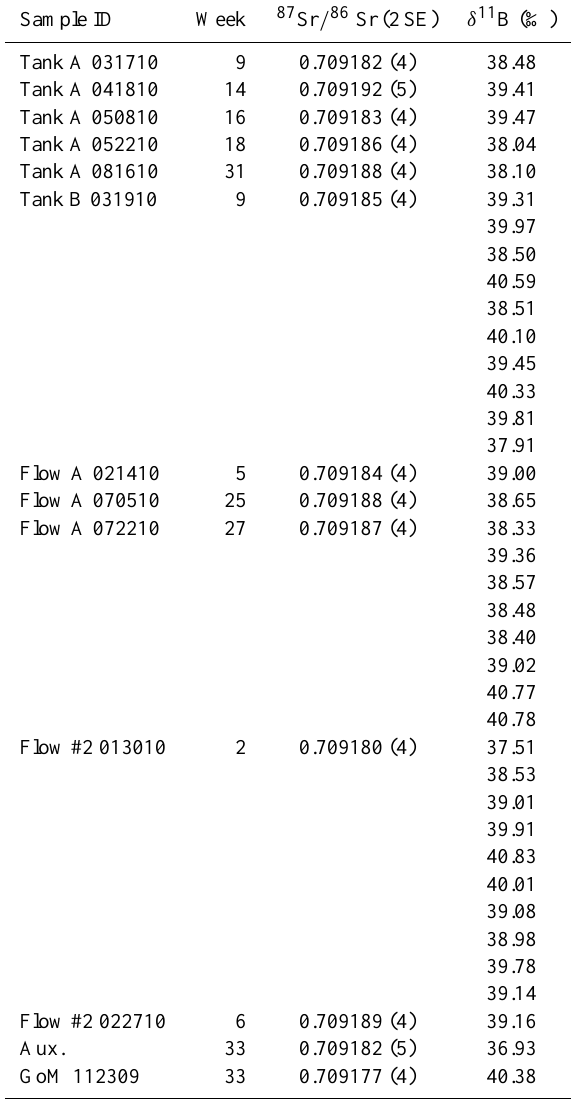
Table 2. Summary of seawater data.